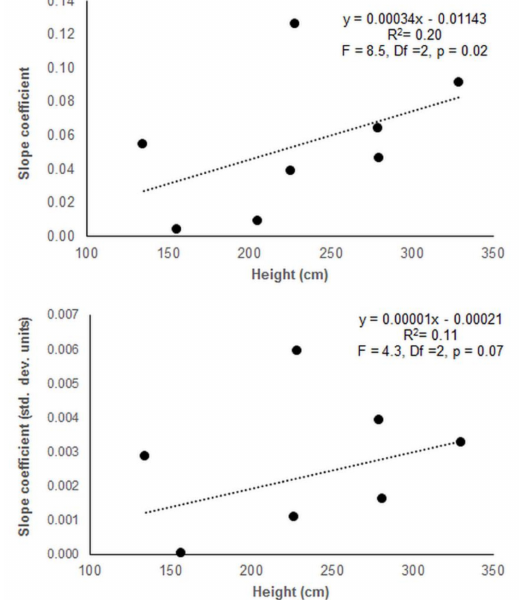
Figure 8. Relationship between growth conditions in test sites and the e ff ect of provenance on tree growth. Site-specific growth conditions are expressed as the overall mean height reached by all trees growing in a given test site, while the e ff ect of provenance was expressed as the slope coe ffi cient of the regression of mean tree heights for provenances against the geographic distances between their origin sites and the meeting zone of the refugial lineages. In the calculations of the regression, absolute and standardized values of tree heights were used to eliminate the direct e ff ect of site variation between the test locations on the slope coe ffi